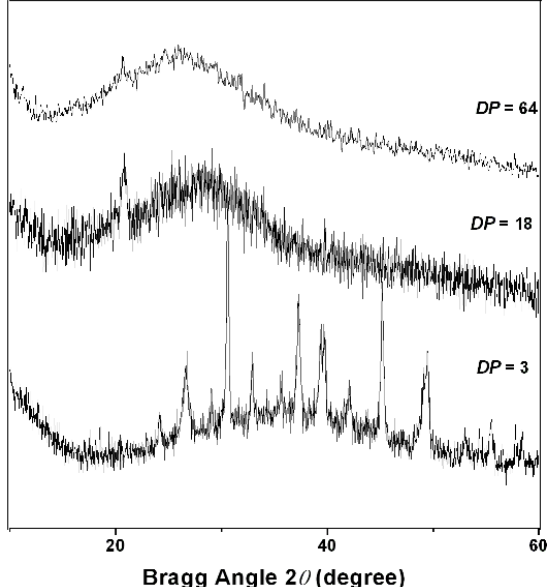
Figure 7. X-ray diffractograms of PAPy with different DP .